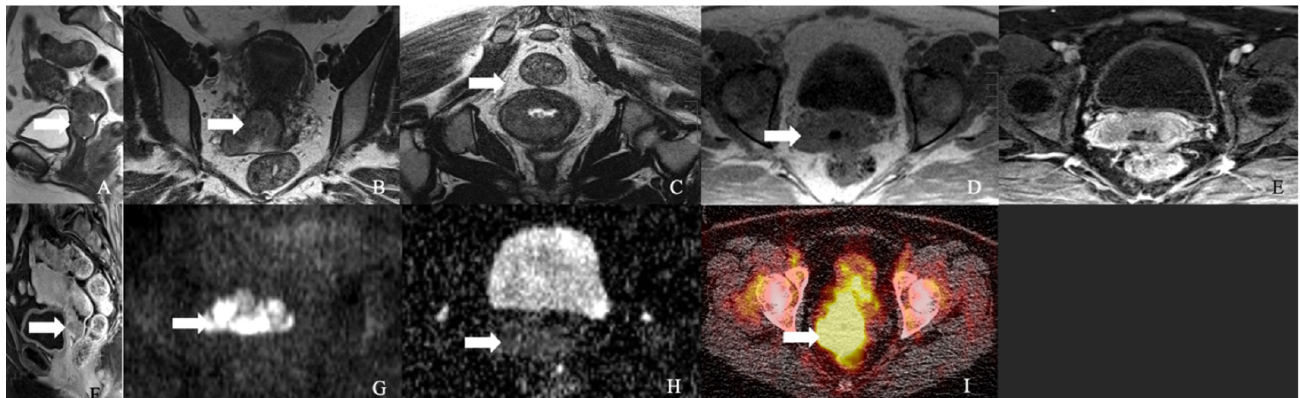
Figure 3. A 62-year-old female with neuroendocrine carcinoma of the cervix. ( A ) Sagittal T2 weighted image, ( B ) axial T2 weighted image, ( C ) oblique T2 weighted image, ( D ) axial pre-contrast T1 weighted image, ( E ) axial fat-saturated post-contrast T1 weighted image, ( F ) sagittal fat-saturated post-contrast T1 weighted image, ( G ) axial diffusion-weighted images (B-100), ( H ) axial apparent diffusion coefficient MRI images, and ( I ) Axial Ga-68 dotatate PET/CT image demonstrate a FDG avid enhancing mass in the cervix (arrow) with restricted diffusion and no parametrium involvement. The mass biopsy reported a small cell neuroendocrine carcinoma.